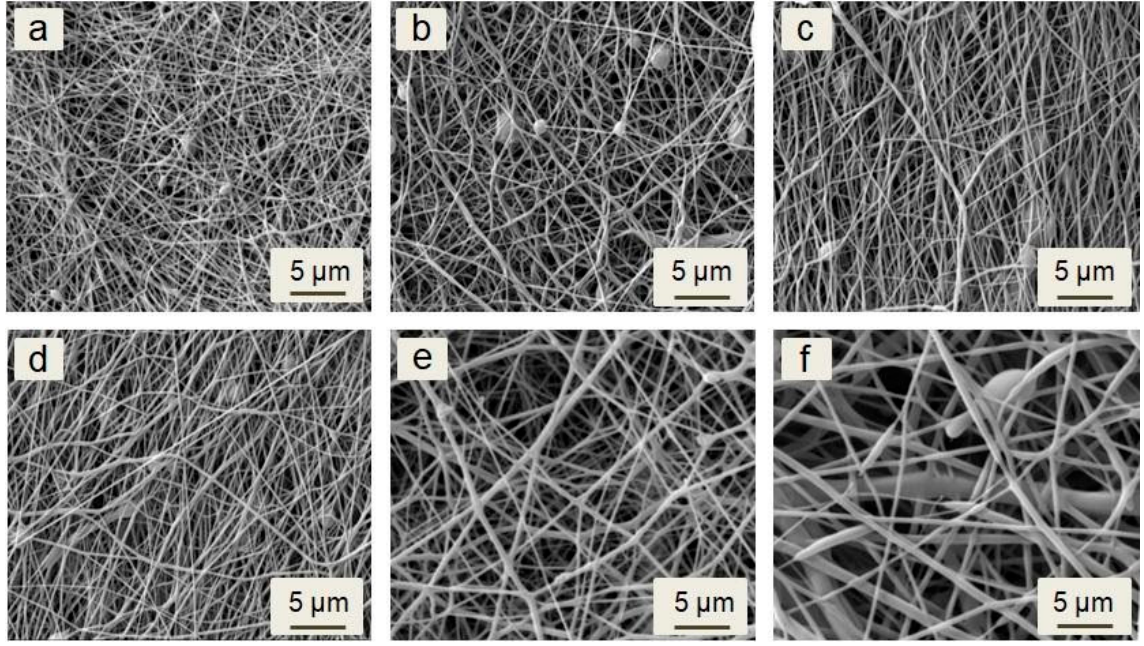
Figure 1. SEM micrograph of electrospun plain PCL ( a ), PCL/2% N ( b ), PCL/6% N ( c ), PCL/12% N ( d ), PCL/25% N ( e ), and PCL/50% N ( f ) fibrous membranes.